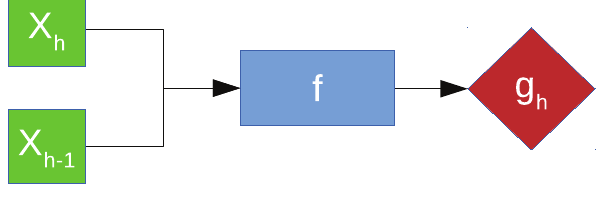
Figure 9. Proposed